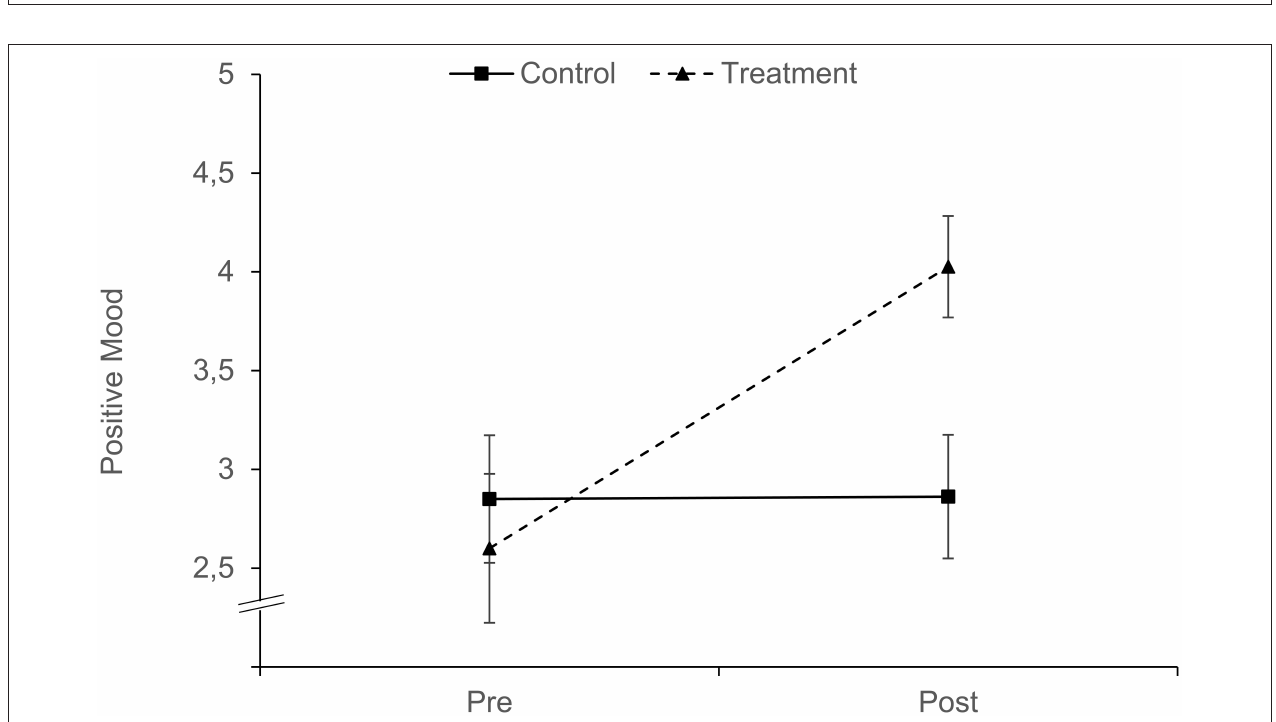
FIGURE 5 | Positive mood by condition by time point. Error bars represent 95% CI.